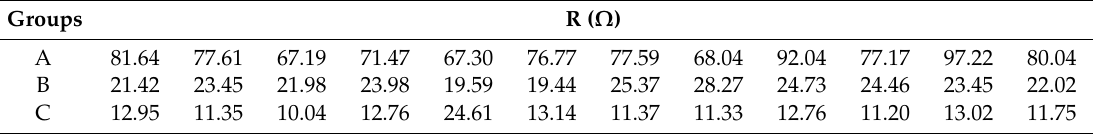
Table 2. Dynamic resistance (R) of all quartz crystal microbalance